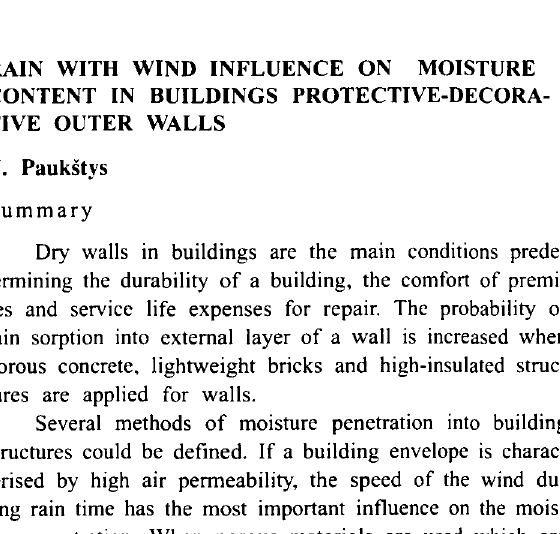
Table 2. Coefficient values Lietaus